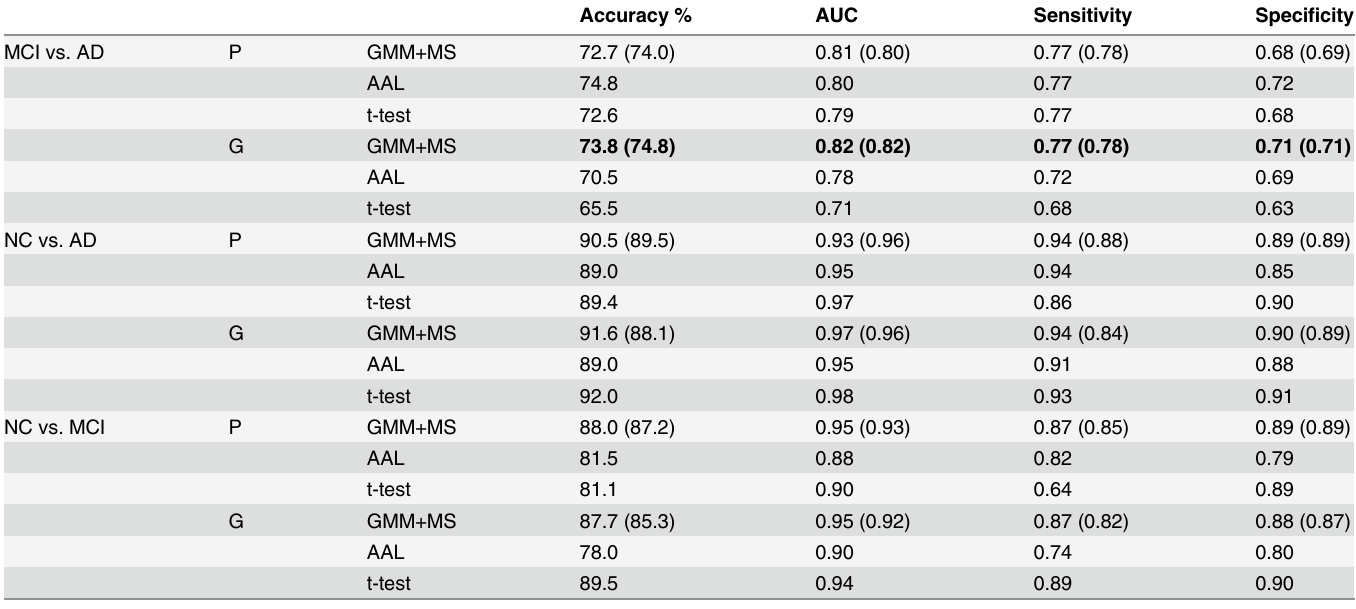
Table 5. Result summary of three different methods on TUM